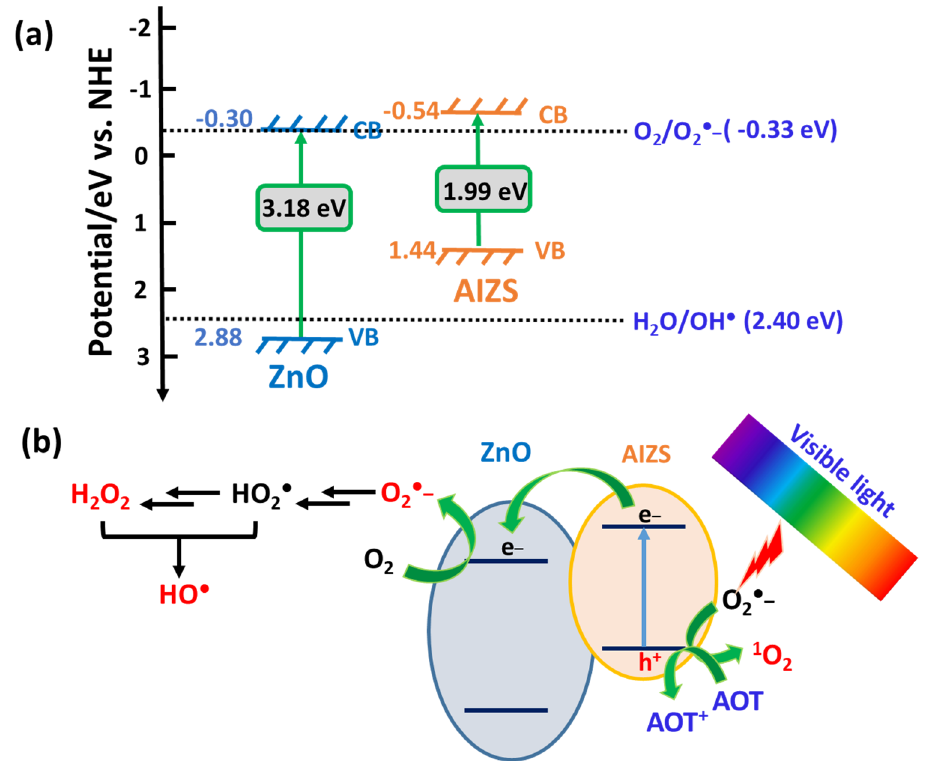
Figure 9. ( a ) Energy band positions of AIZS QDs and ZnO NRs and ( b ) mechanism of the visible light ‐ driven photodegradation of AO7 using the ZnO/AIZS(10) photocatalyst.